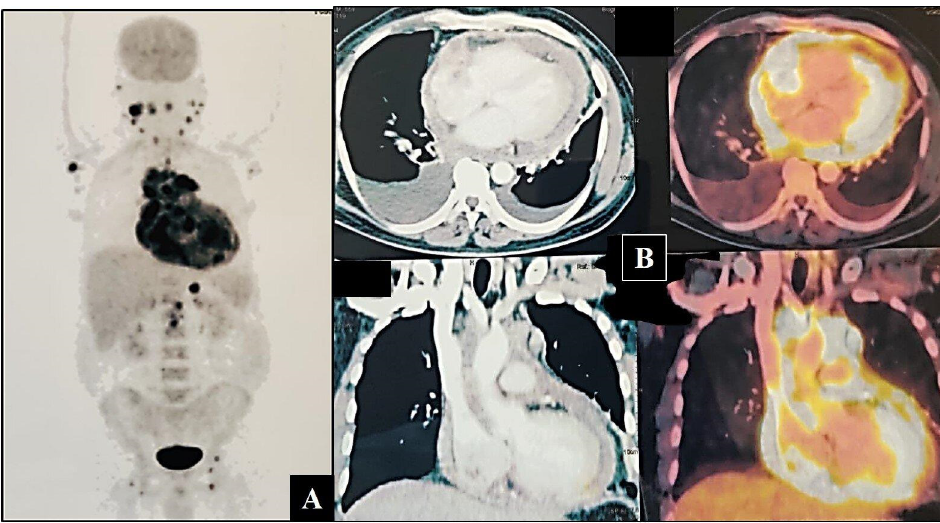
on morphology and immunohistochemistry, Ann-Arbor stage IV, and IPI (International Prognostic Index) score of 3.